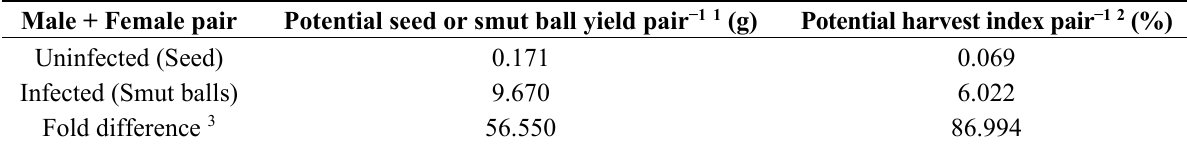
Table 4. Potential seed yield and potential harvest index (yield/total biomass) for pairs of male and female buffalograss either infected or uninfected with the pistil smut fungus. Uninfected females yield seed (endosperm filled caryopses) while infected males and females yield smut balls (teliospore filled